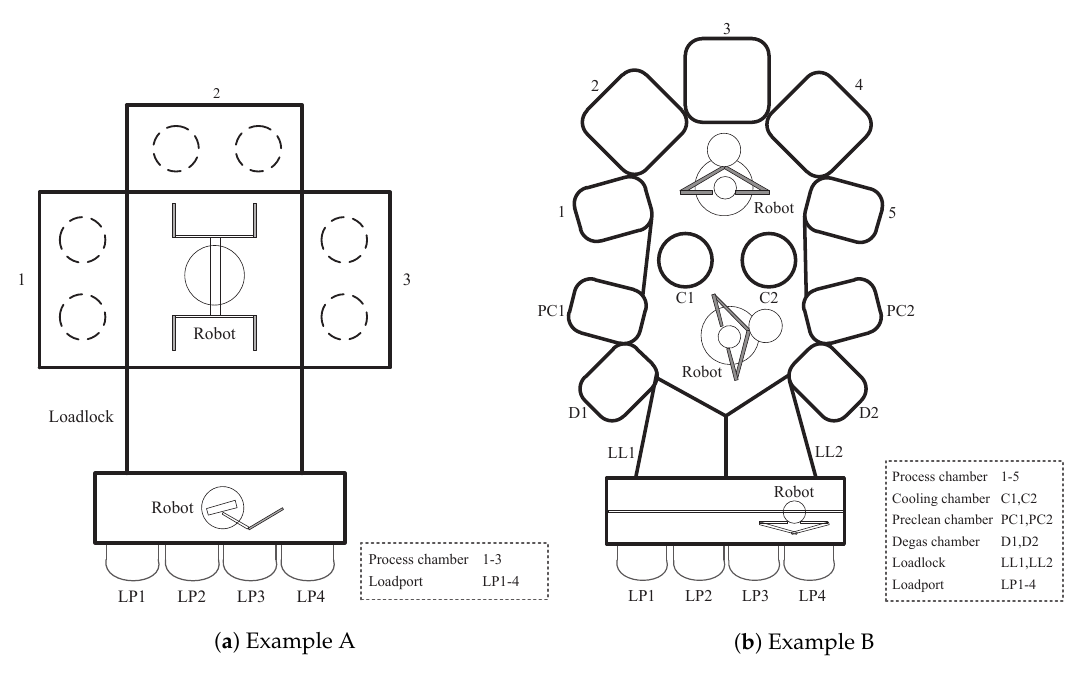
Figure 2. Example schematics of integrated processing